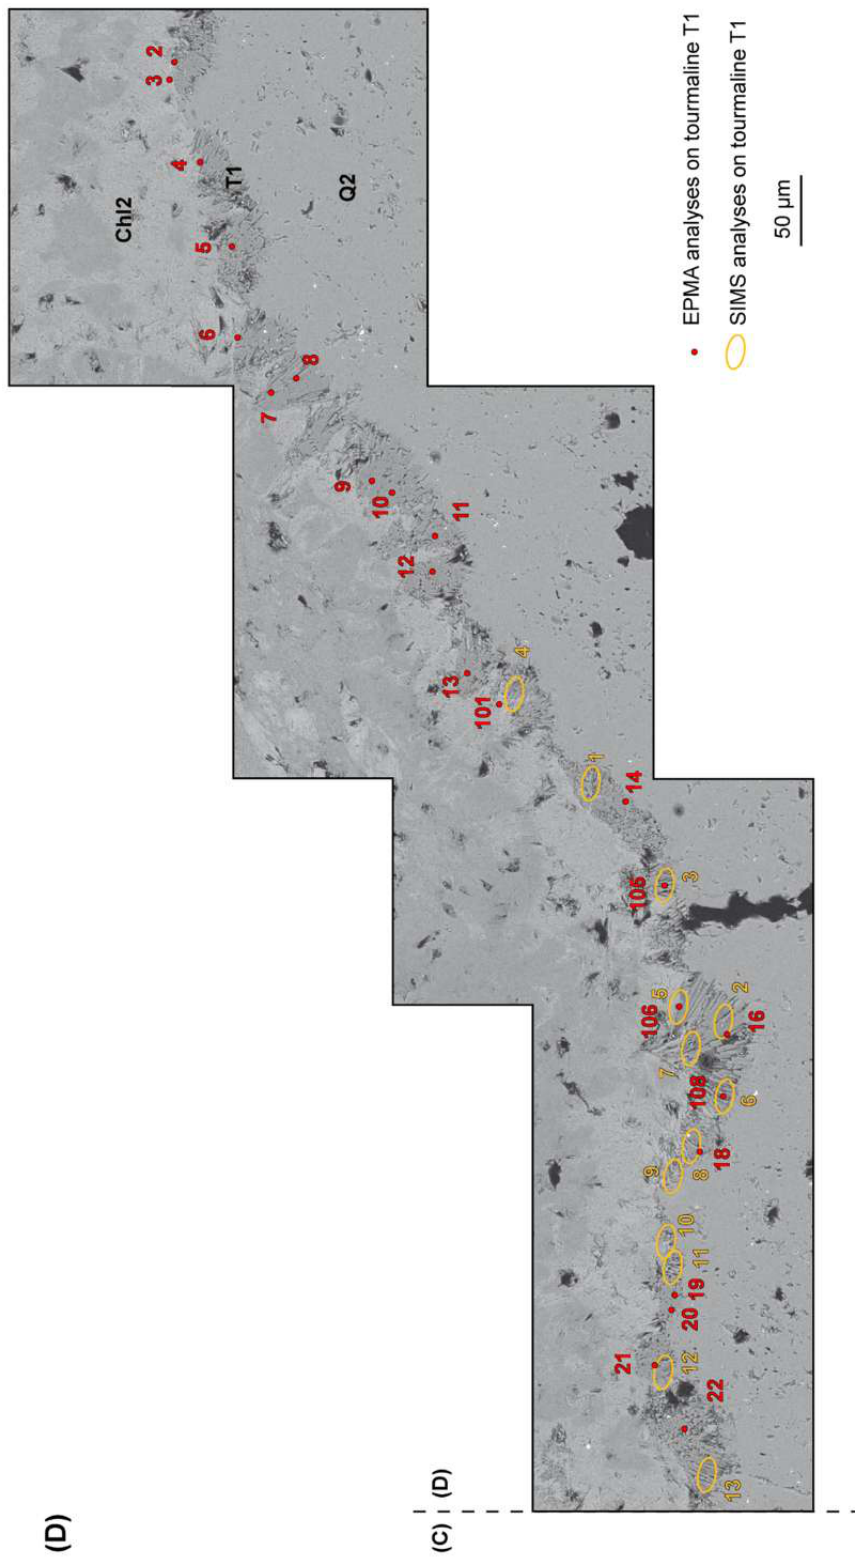
Figure 6. Locations of the EPMA (red dots for the tourmaline T1 and green dots for the chlorite Chl2) and SIMS (orange ellipse) in situ analyses. ( A ) BSE map of sample from drillhole S3PD759 402.9 m. The paragenetic assemblage of the pre-ore silicification minerals from the Ranger U deposit (Australia) consists of chlorite Chl2, followed by tourmaline T1 and then by quartz Q2. The insets indicate the location of BSE maps ( B – D